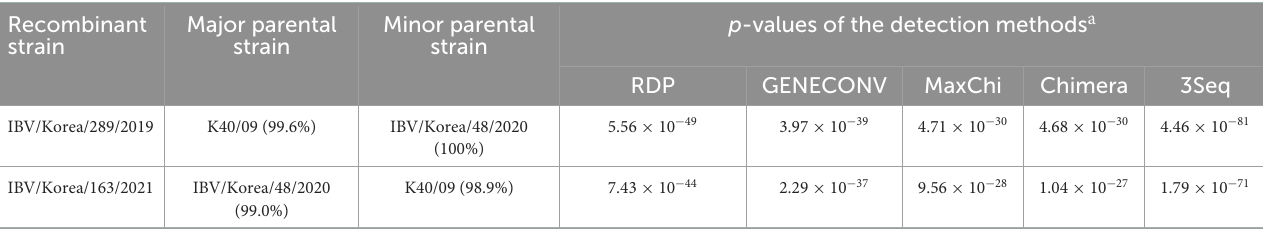
TABLE 1 Recombinant detection of S1 gene in IBV isolated in this study. Recombinant